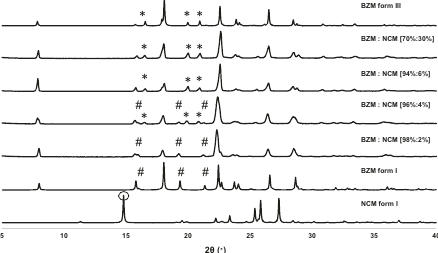
Fig. 3 Outcome of the solvent mediated phase transformation experiments. PXRD patterns of slurry products obtained from mixtures of BZM and NCM in IPA at different total BZM:NCM concentrations (in mol% in brackets). Patterns of pure forms are given for comparison (peaks indicated with hashes are typical of BZM form I whilst peaks indicated with asterisk are typical of BZM form